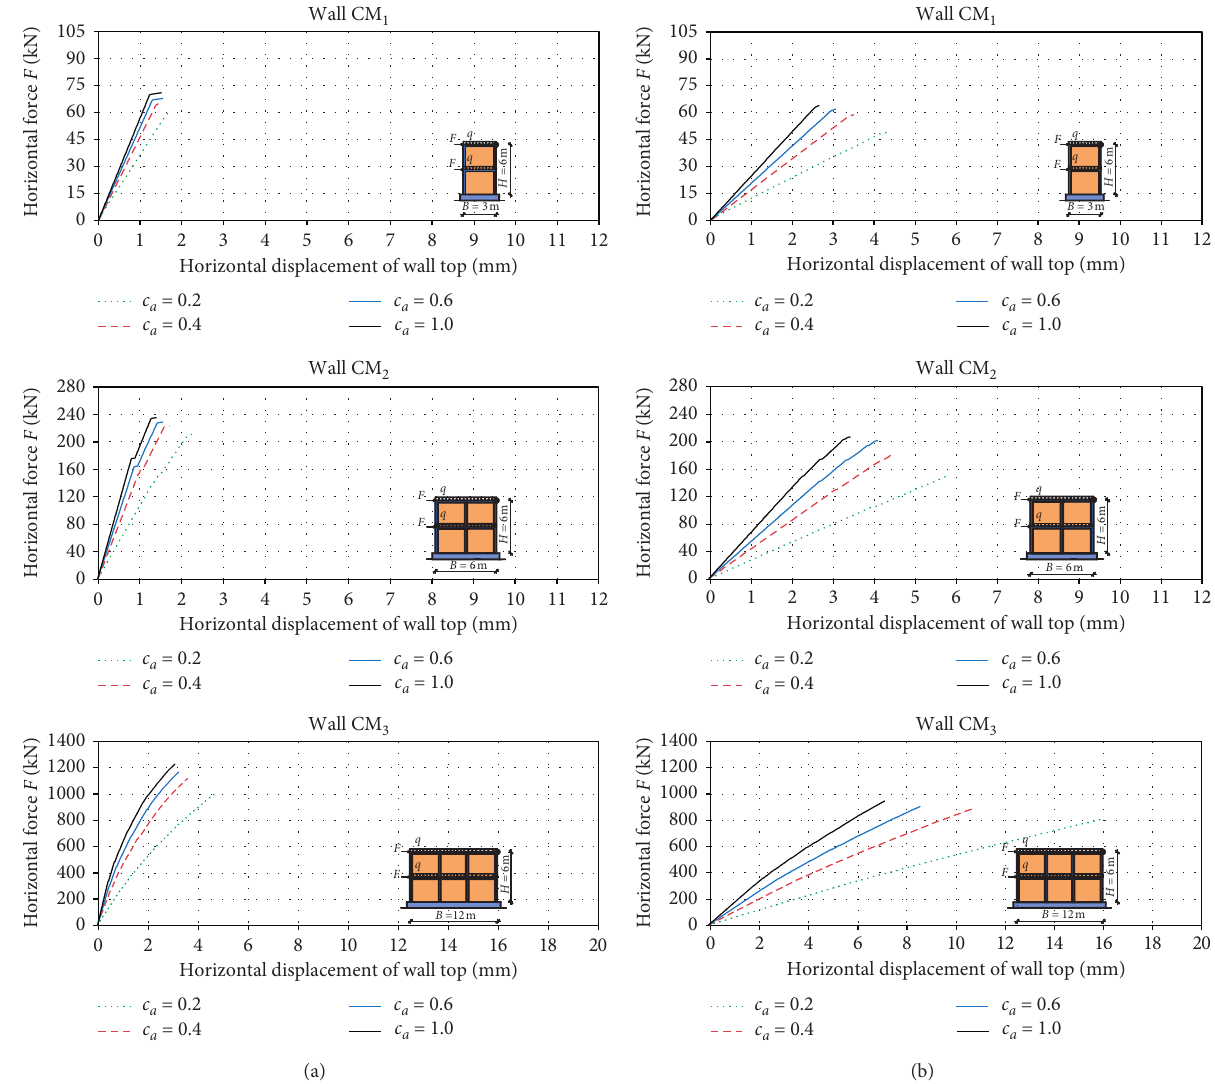
Figure 10: Horizontal displacement of the top of confined masonry walls: (a) stiff masonry; (b) soft